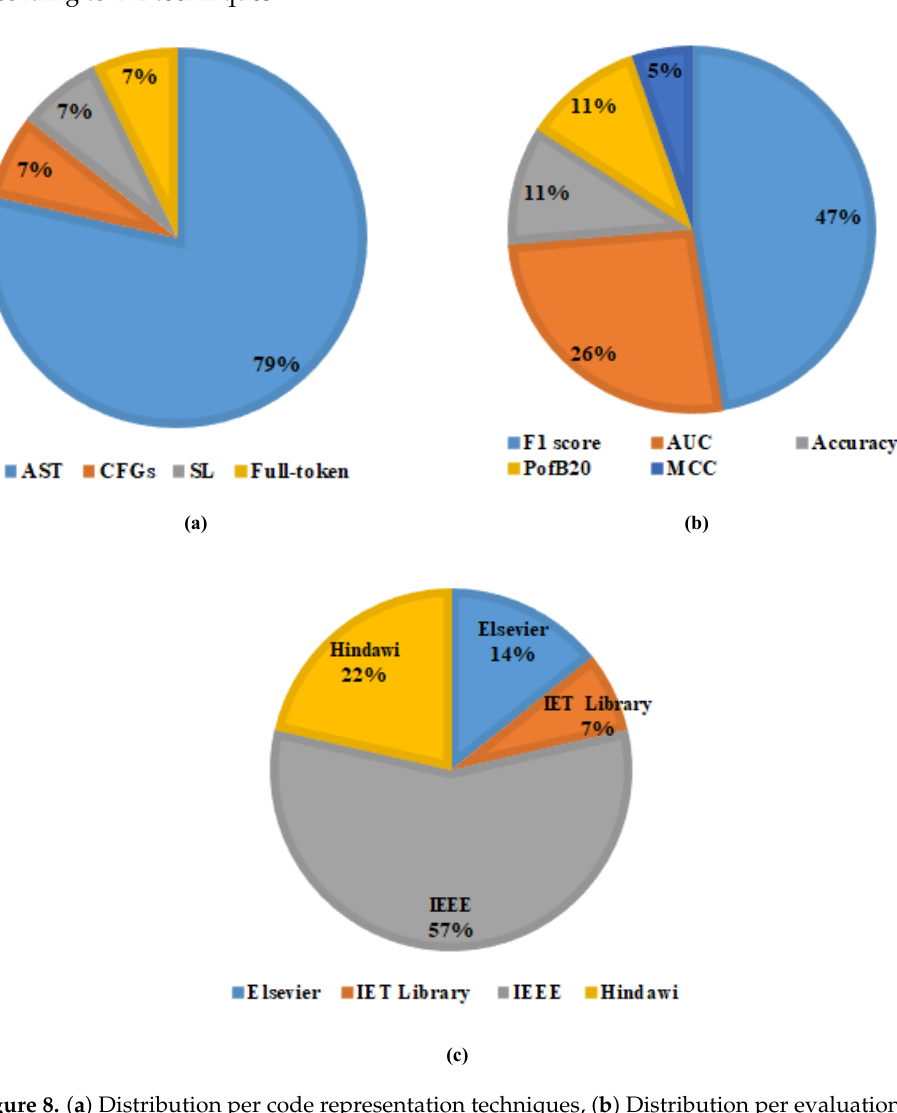
Figure 8. ( a ) Distribution per code representation techniques, ( b ) Distribution per evaluation mea- sures, and ( c ) Distribution per online libraries.